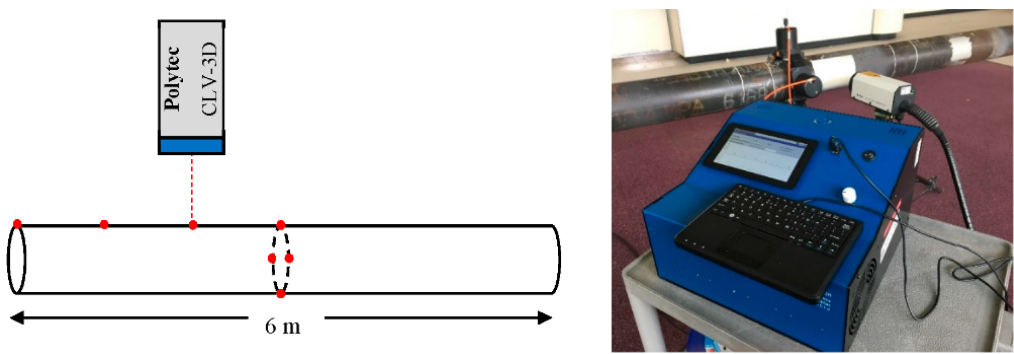
Figure 12. Point data along the length of pipe using Polytec CLV-3D Laser Vibrometer.